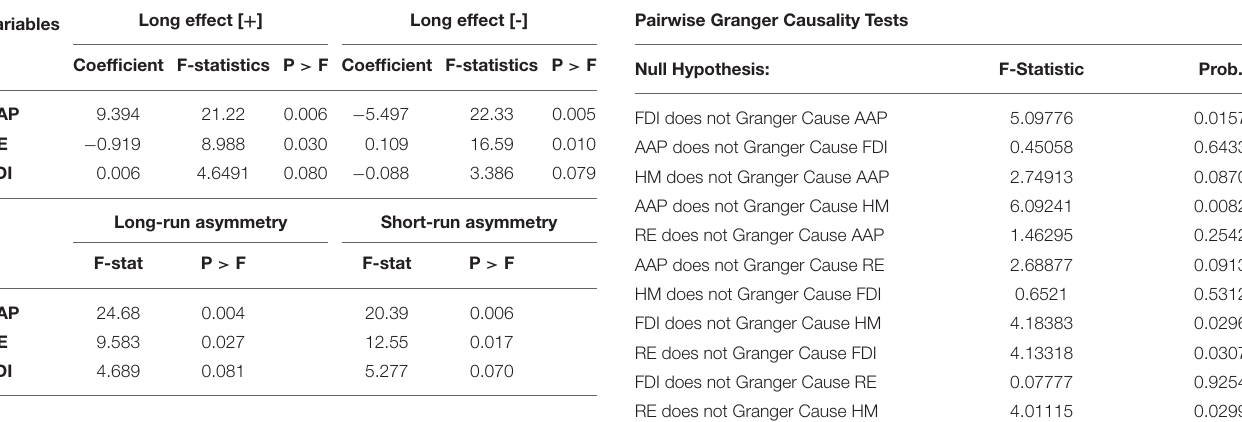
TABLE 3 | Long-run estimations.